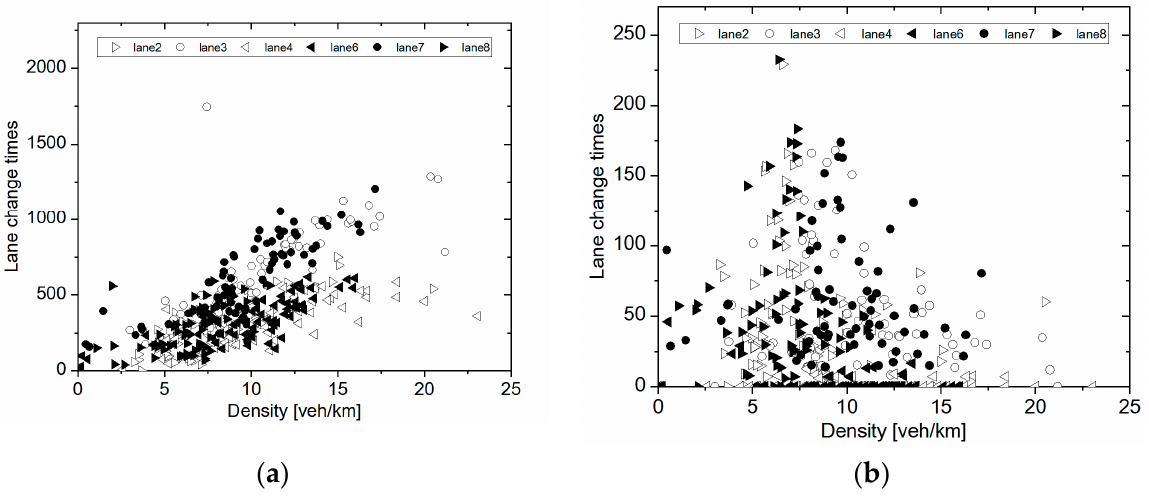
Figure 8. ( a ) Car lane change times versus density; ( b ); Truck lane change times versus density.